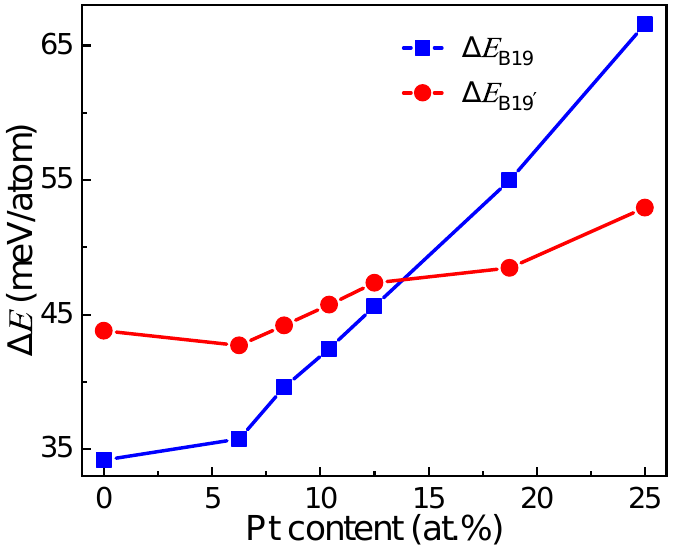
Figure 6. The energy differences between austenite and martensite ( ∆ E ) as a function of the doping concentration in Ti 50 Ni 50 − x Pt x alloys.